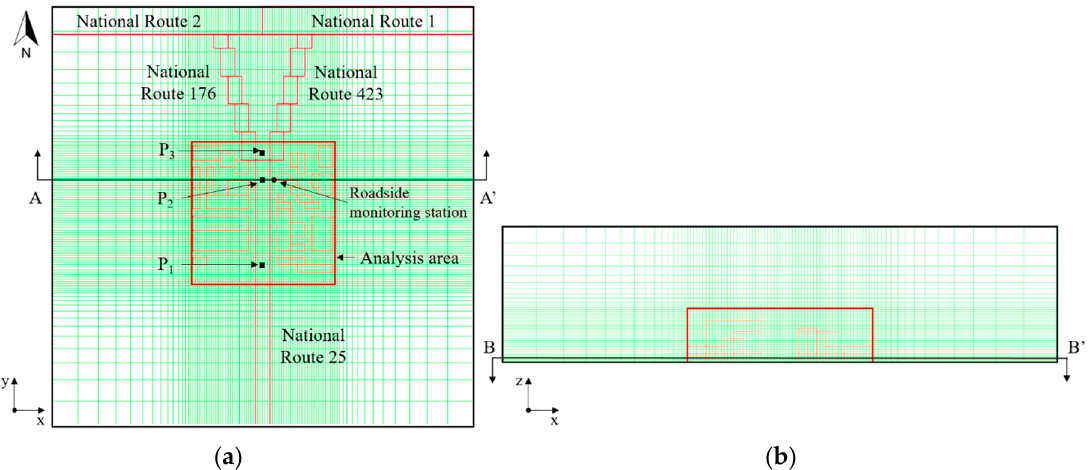
Figure 2. Mesh view of the CFD calculation domain and analysis area. ( a ) the x–y view shows the reference points P 1 located at y = 230 m, point P 2 and cross-section A-A’ located at y = 350 m, and